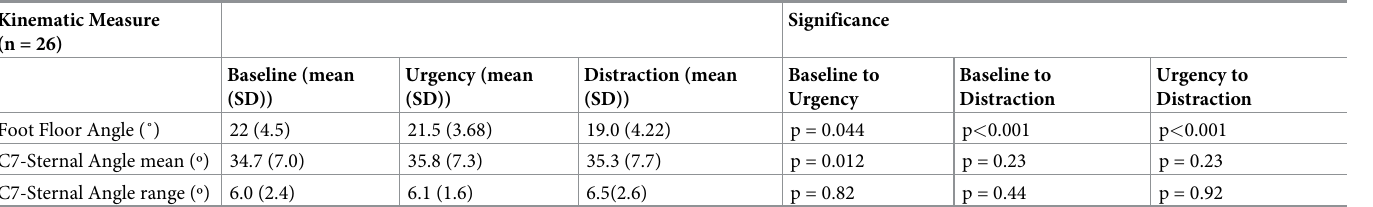
Table 3. Kinematic gait analysis.